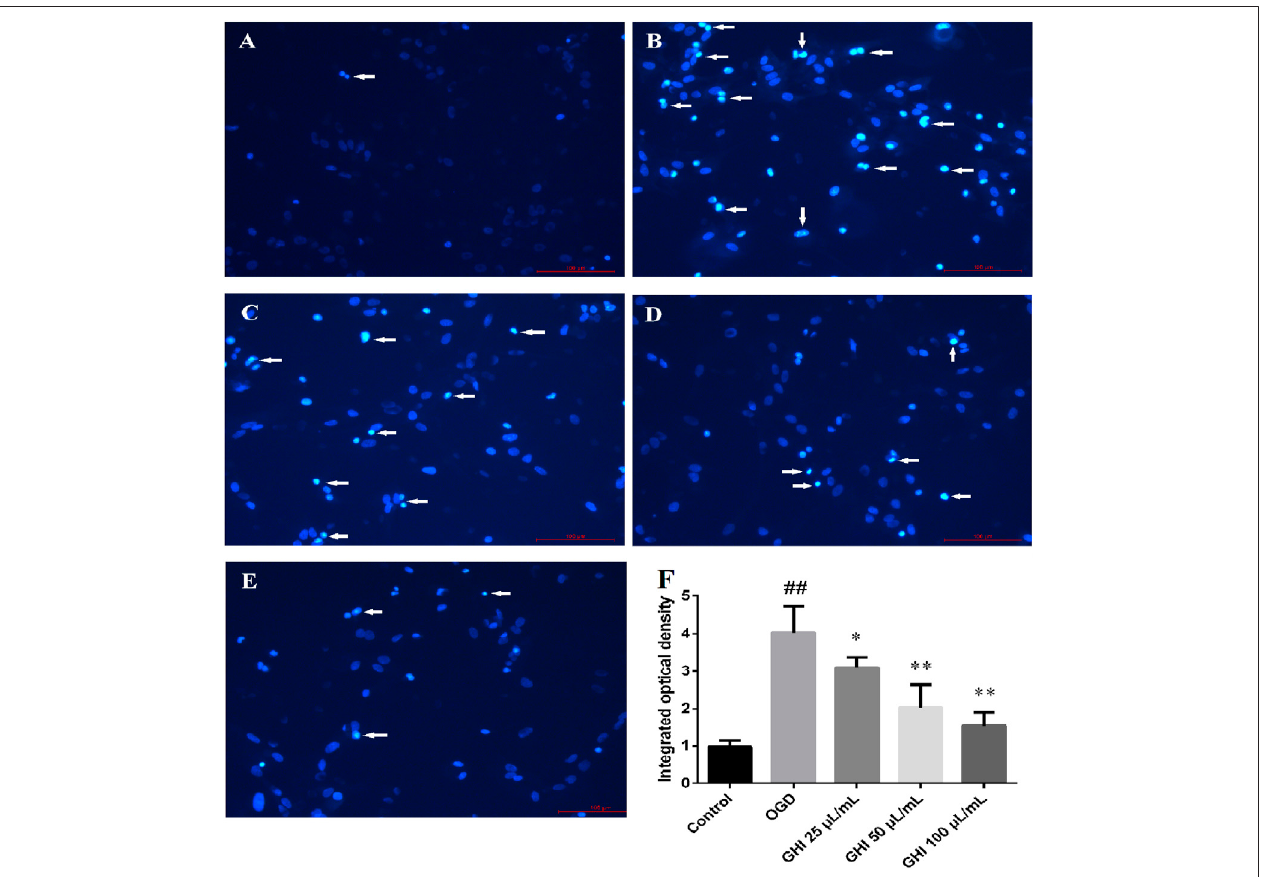
FIGURE9| Effects ofGHIonhistochemicalcharacterizations ofrBMECs inOGD injury(n (cid:2) 6). Arrowheadsin thepictures indicate thenucleiofapoptosis cells. (A) Control group, (B) OGD group, (C) GHI 25 μ L/ml, (D) GHI 50 μ L/ml, (E) GHI 100 μ L/ml, and (F) integrated optical density. ## P < 0.01 compared with the control group; * p < 0.05, ** p < 0.01 compared with the OGD